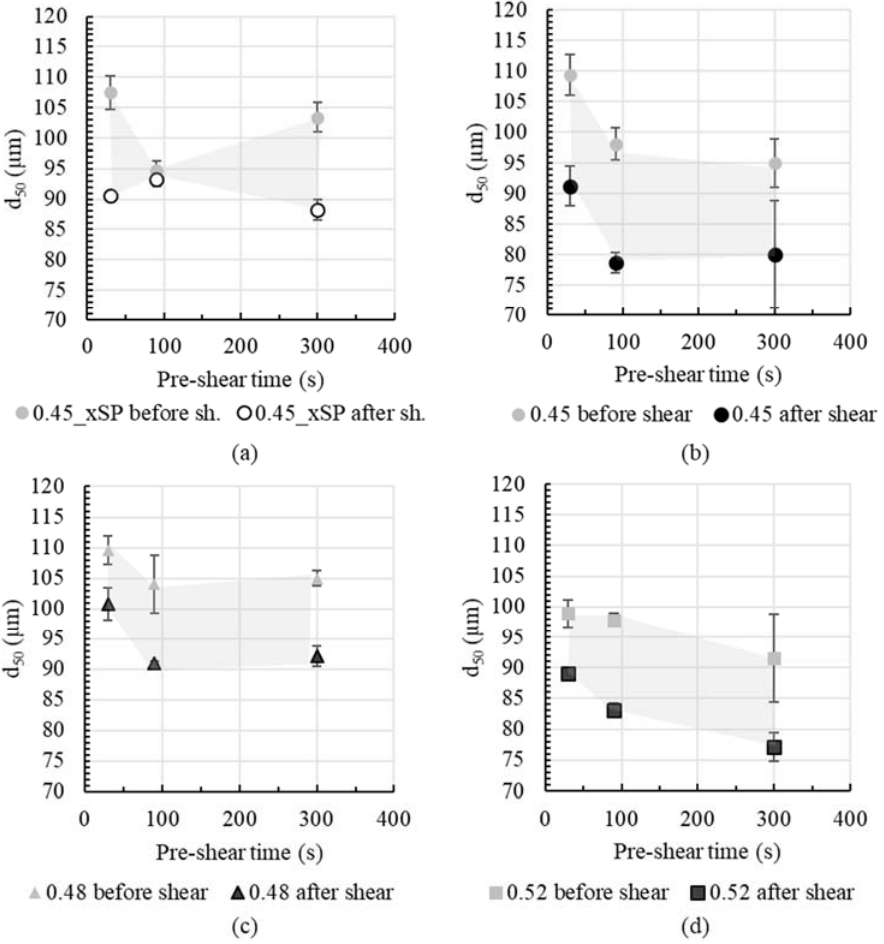
Figure 5. Agglomerate size d 50 of cement paste with various solid volume fractions ( a ) 0.45_xSP (without superplasticizer), ( b ) 0.45, ( c ) 0.48 and ( d ) 0.52 over pre-shear time before and after applied shear. The grey area indicates the agglomerate size decrease during shear.